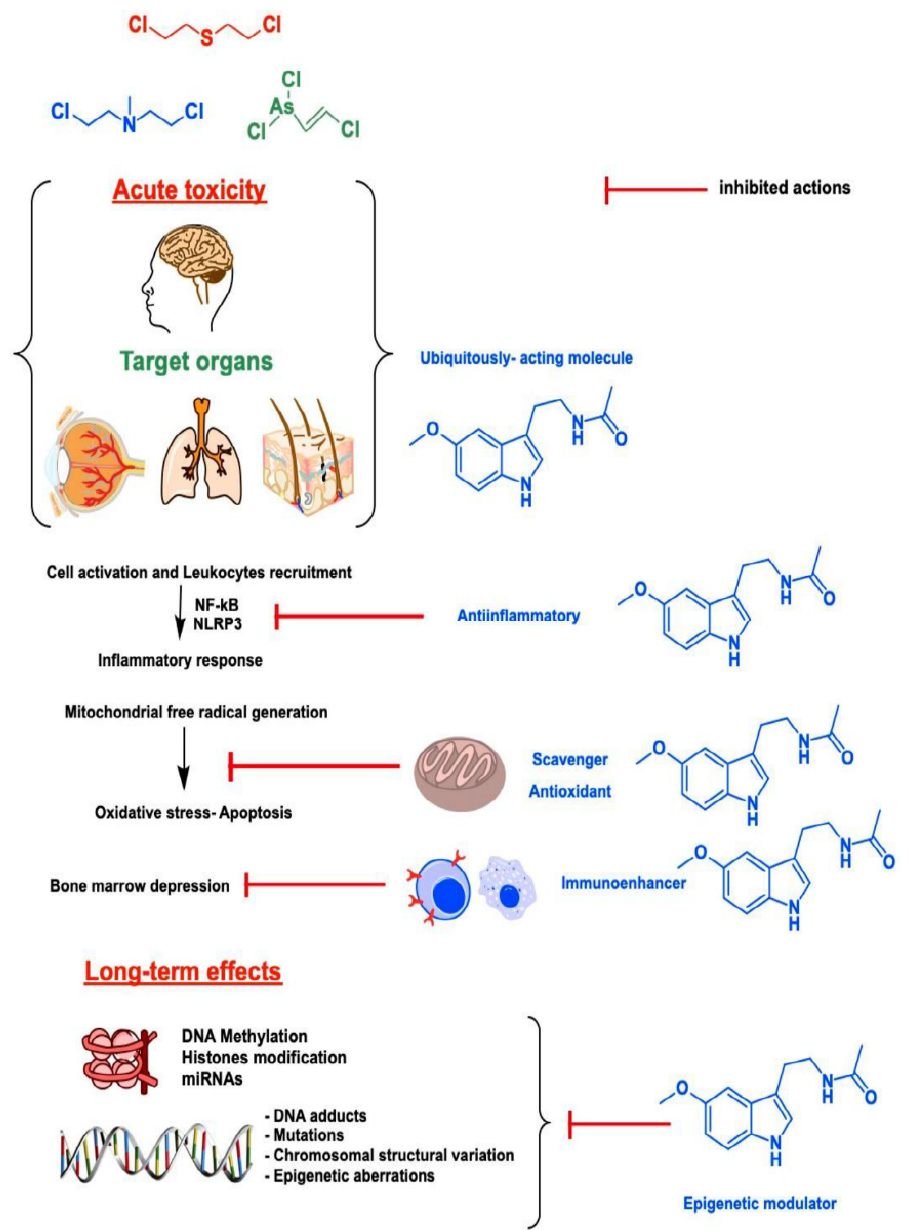
Figure 5. Summary of the cellular and molecular mechanisms displayed by melatonin against vesicant chemical warfare agents (CWAs). From Romero et al. [38], with permission.